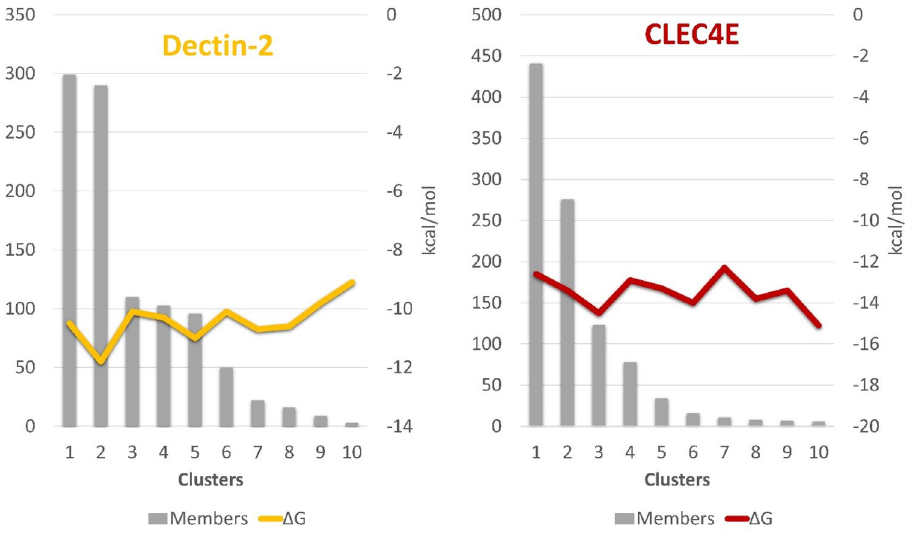
Figure 7. Molecular dynamics strategies of CVX/CLEC4E and CVX/Dectin-2 simulations. The graphs above exhibit the 10 most populated clusters (grey bars) extracted from the MD trajectories of CVX/CLEC4E and CVX/Dectin-2 simulations, relating the number of members per cluster and the variation in binding energy among the representants (central structure) of each cluster (red and yellow lines).